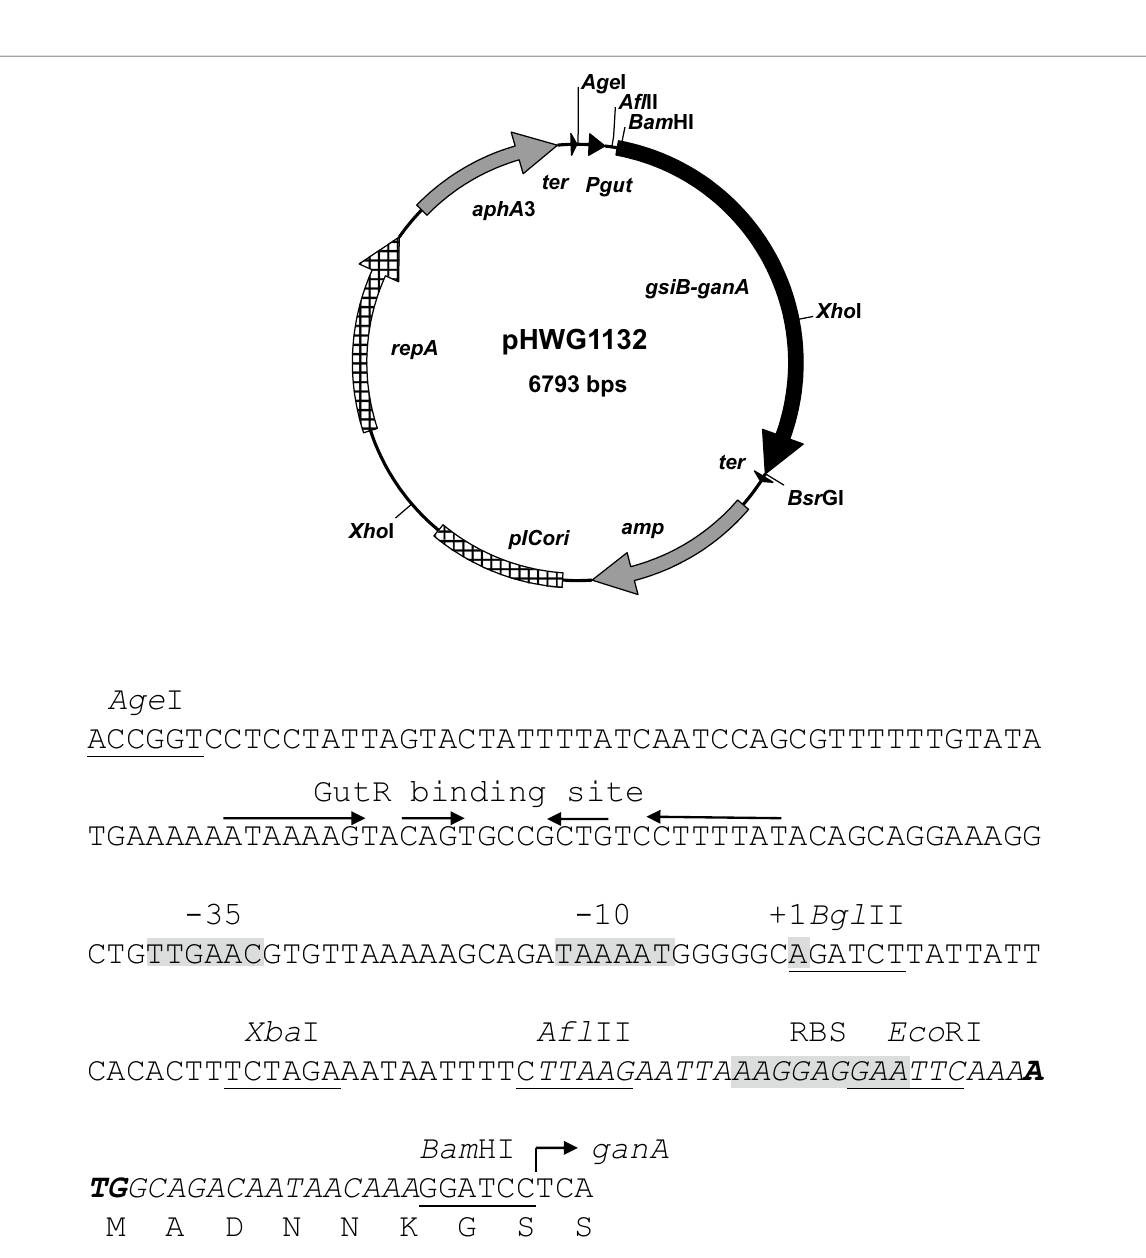
35, 10 and 1 sequence (grey blocks). The sequence derived from gsiB is shown in italics, − − +